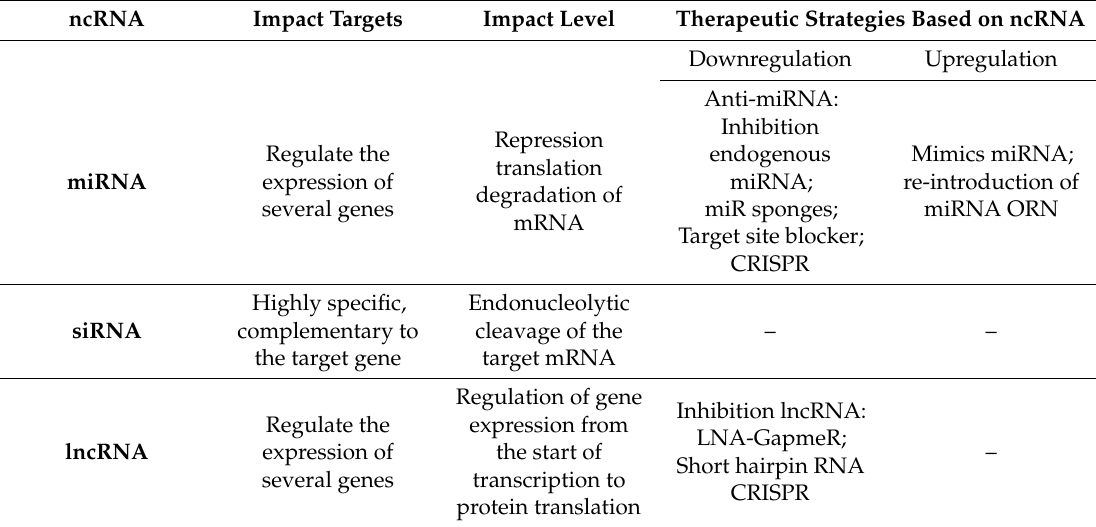
Table 1. The mechanism of action of noncoding